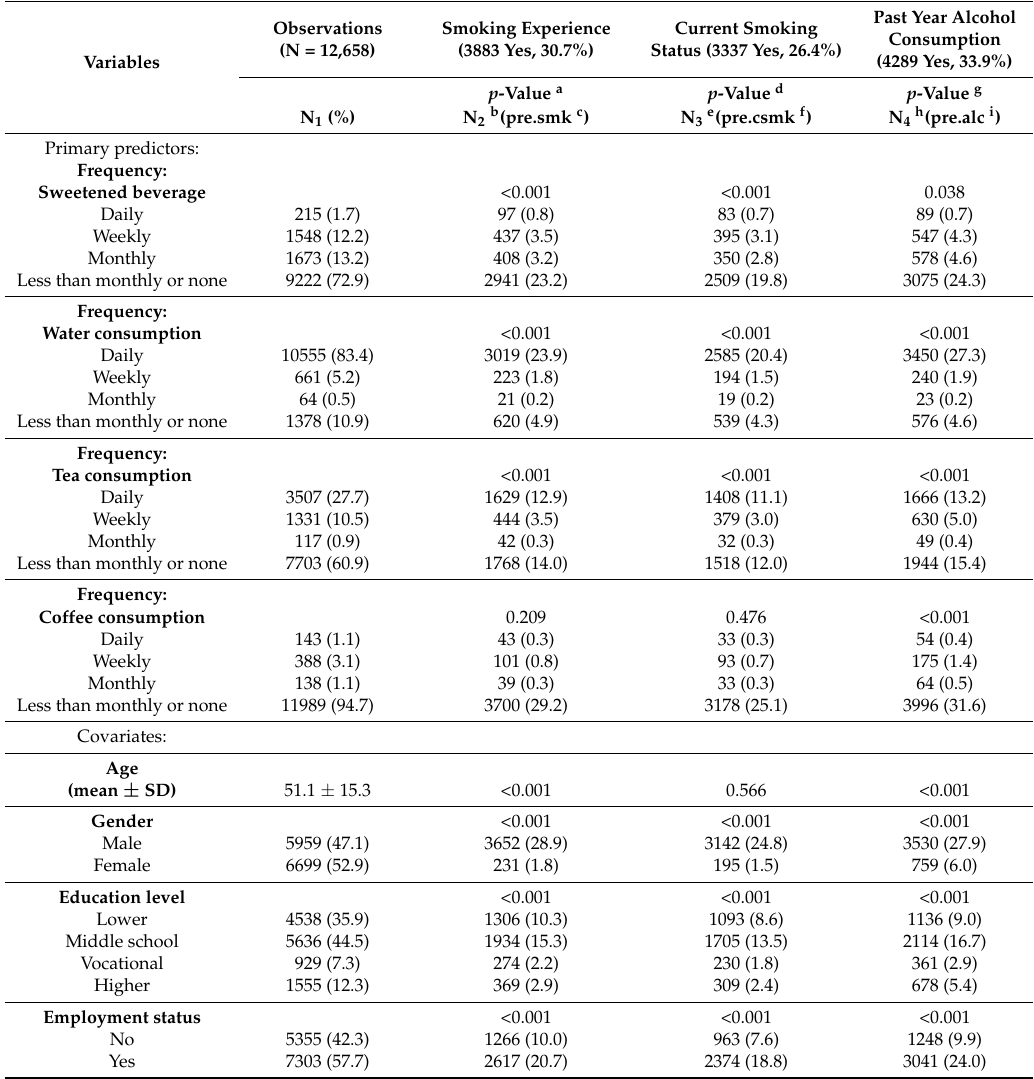
Table 1. Descriptive statistics, prevalence rates by variables, and crude examinations for study sample ( n = 12,658). Data source: Chinese Health and Nutrition Survey, 2011 . Observations Smoking Experience Current Smoking (N = 12,658) (3883 Yes, 30.7%) Status (3337 Yes, Variables